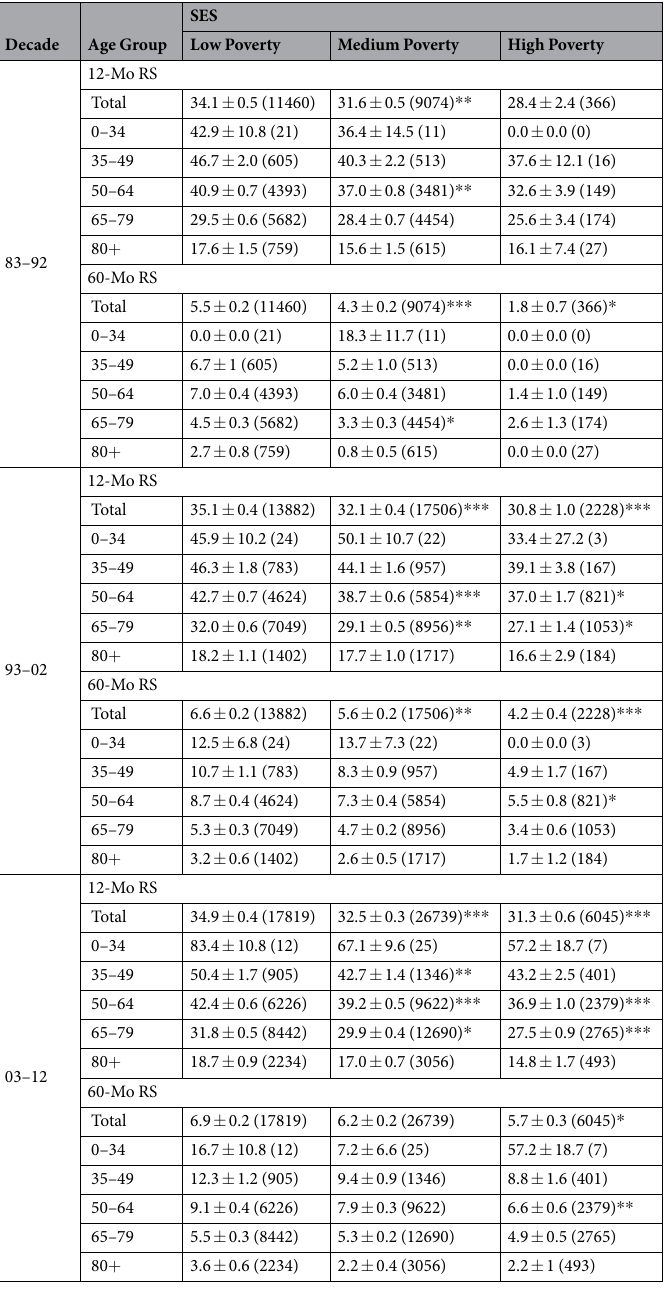
Table 4. 12-month and 60-month relative survival rates of SCLC patients according to SES, age group, and calendar period from 1983 to 2012 at 18 SEER sites. Data are means ± standard error of the mean, with number of patients in parentheses. Abbreviations: Mo, month; RS, relative survival; SEM, standard error of the mean. * p < 0.01, ** p < 0.001, and *** p < 0.0001 for comparisons with the Low Poverty